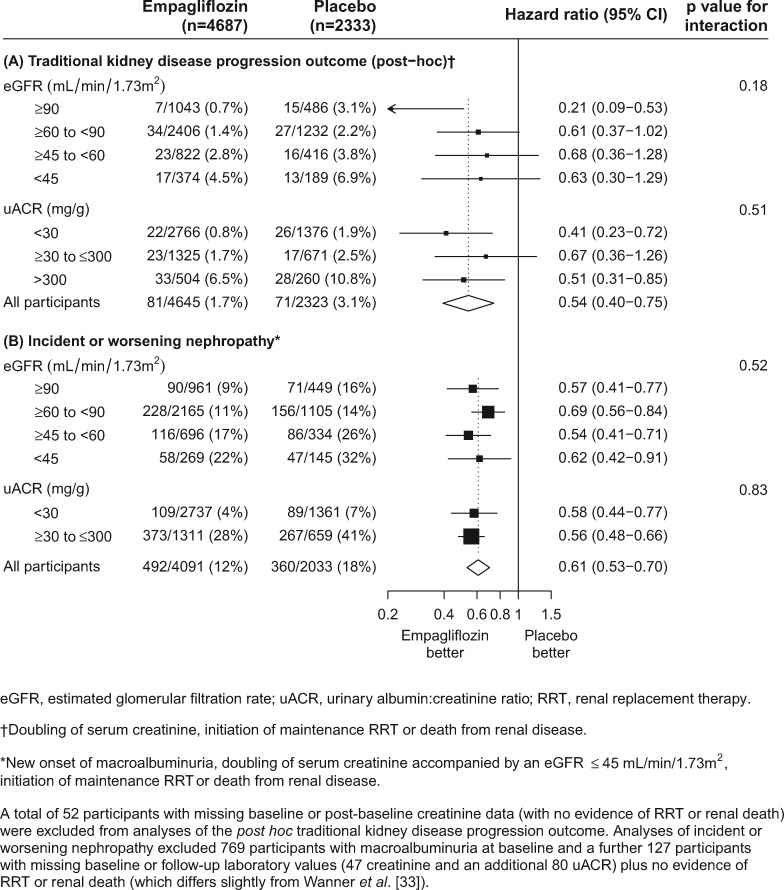
Effect of allocation to empagliflozin versus placebo on (A) traditional kidney disease progression outcome (post hoc) and (B) incident or worsening nephropathy, by baseline eGFR and uACR.